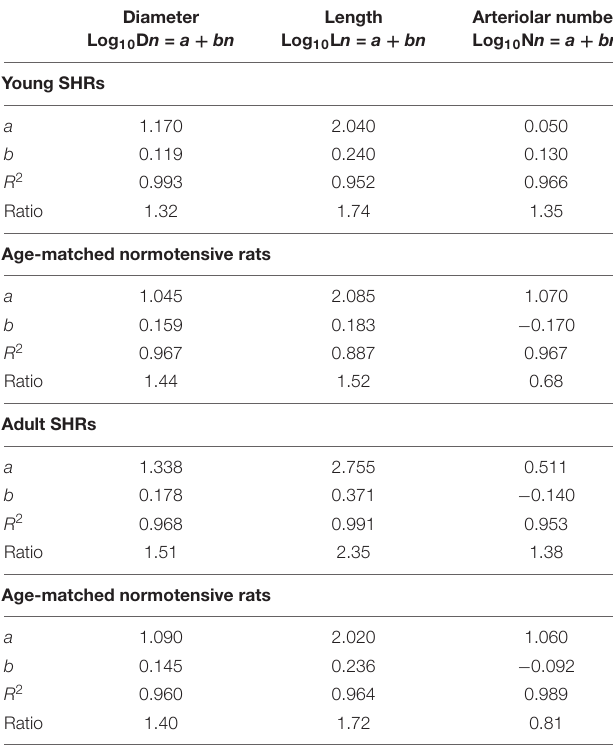
TABLE 2 | Values of the empirical constants a and b that described the semilogarithmic relationships between the mean diameter, length, number of vessel elements, and order number of arterioles in young spontaneously hypertensive rats (SHRs) and age-matched normotensive rats and in adult SHRs and age-matched normotensive